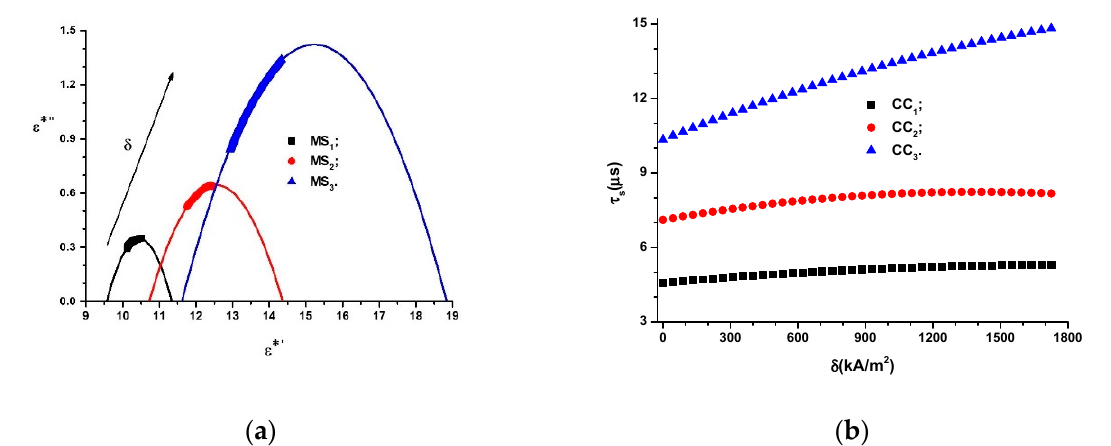
Figure 16. ( a ) Dependence of the apparent relative dielectric permittivity, ε ∗ (cid:48)(cid:48) , on the relative dielectric permittivity, ε ∗(cid:48) , of MSs; ( b ) time constant of CCs, τ s , as a function of the magnetic field intensity gradient, δ